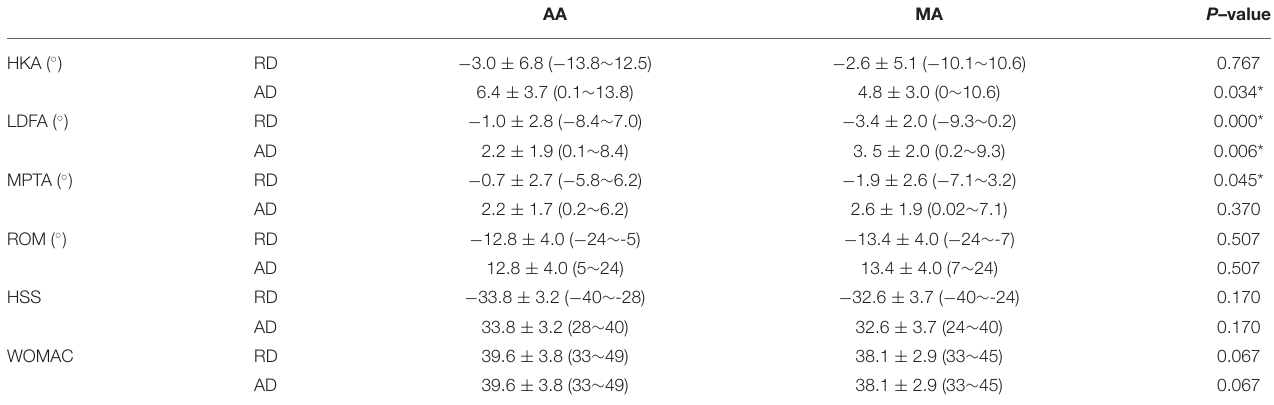
TABLE 4 | Comparison of preoperative minus postoperative values.